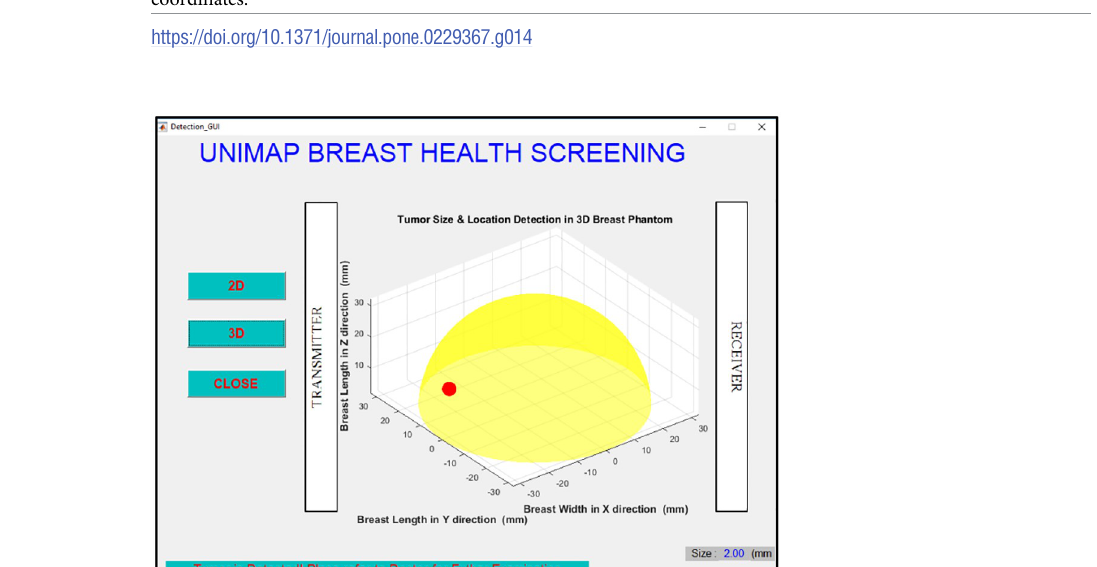
Fig 14. Visualization of detected 2 mm tumor size in 2D environment. Figure shows the example of visualization layout in the 2D environment to detect 2 mm tumor at the location of 2.5 mm, 32.5 mm and 50 mm for x, y and z